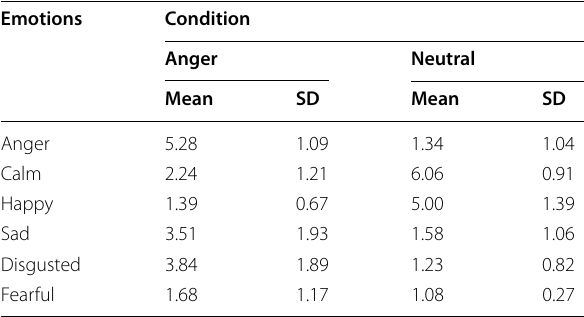
Table 2 Mean self‑reported emotions, separately by emotion condition